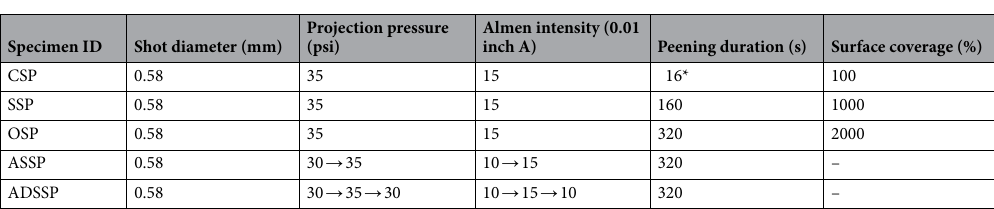
Table 2. Parameters of the applied SP treatments. *16 s for 15A corresponds to the saturation